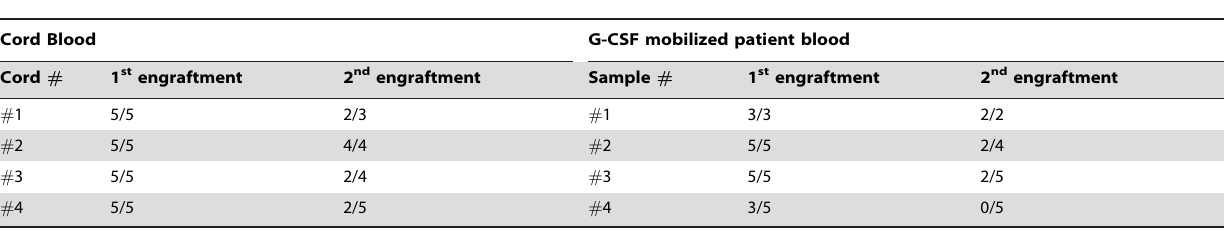
Cohorts of NSG mice were irradiated with given a transplant of cord blood cells or G-CSF mobilized patient blood cells after a 12 day expansion with Tat-MYC/Tat-Bcl-2. The number of engrafted mice in each cohort is shown under 1 st engraftment. Cohorts of NSG mice were irradiated with given a transplant of 10 6 bone marrow cells from primary xenochimaeric NSG mice. Mice were analyzed 8 weeks post-transplant for human CD45 + /CD38 + /CD34 + cells in their bone marrow compartment. The number of engrafted mice after serial transplant is shown under 2 nd